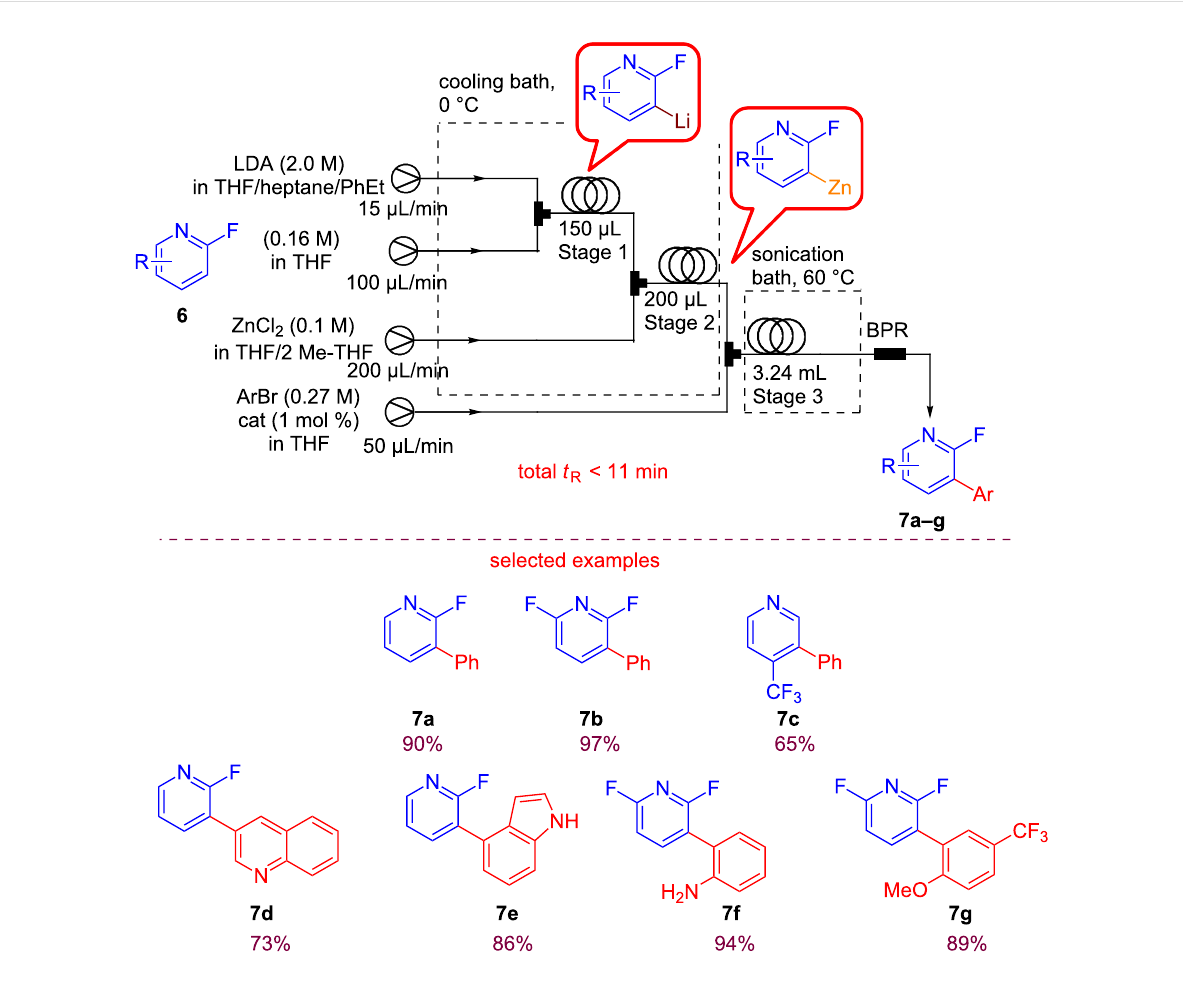
Scheme 10: Experimental setup for the coupling of fluoro-substituted pyridines. (Adapted with permission from [53], copyright 2016 Wiley-VCH Verlag GmbH & Co. KGaA,